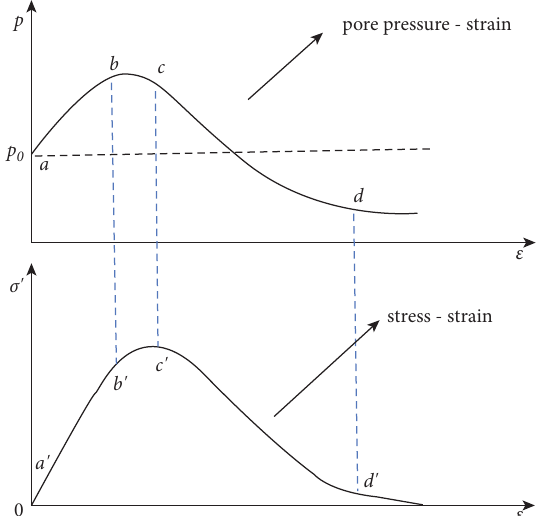
Figure 1: “Pore pressure-stress-strain” relation